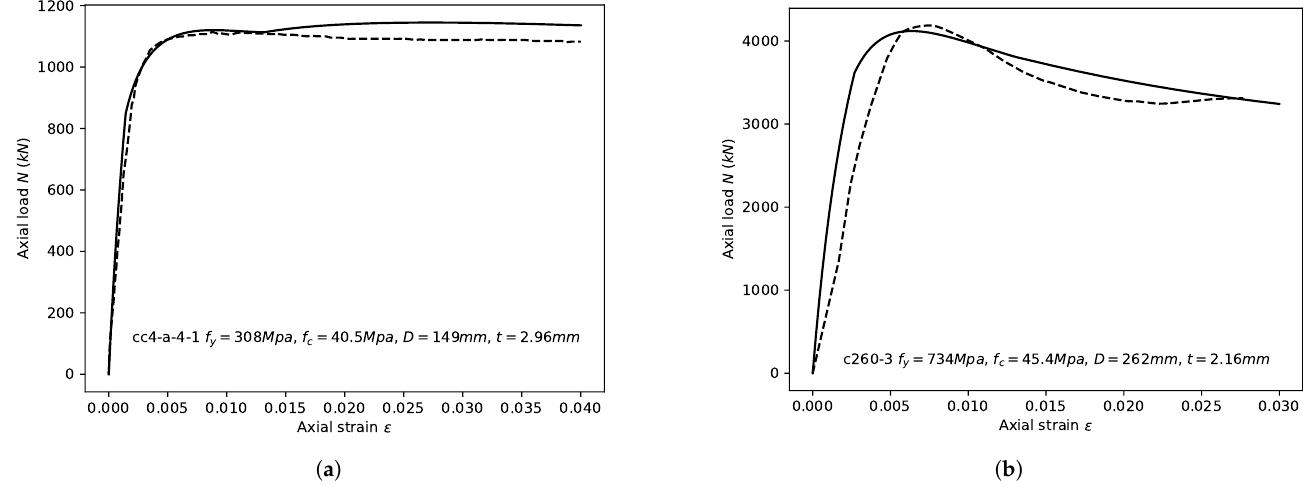
Figure 15. Comparison of calculated axial load–strain curves and the experimental results. ( a ) cc4-a-4-1 [19]; ( b ) c260-3